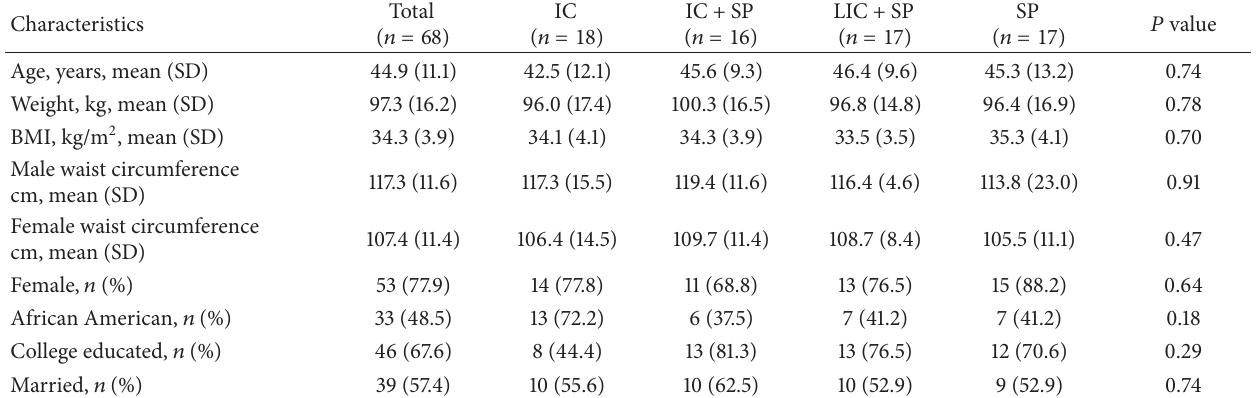
Table 1: Baseline sample characteristics by treatment